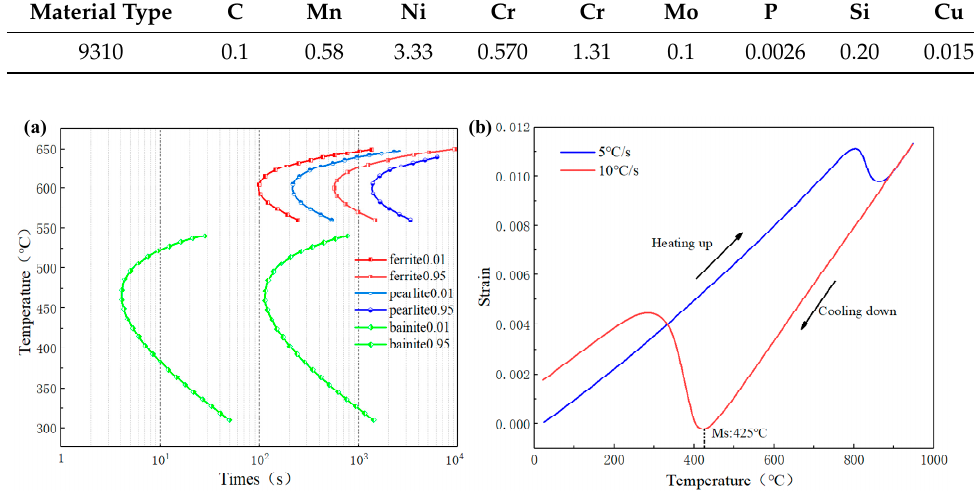
Figure 2. Phase transformation kinetic parameters of 9310 with 0.1% carbon content: ( a ) TTT diagram; ( b ) Dilatometric curve.